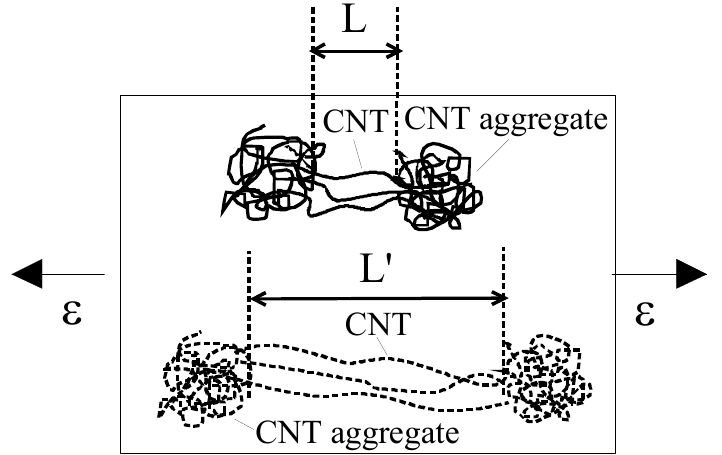
Figure 19. Schematic view of the working mechanism of LMWNT-10/epoxy